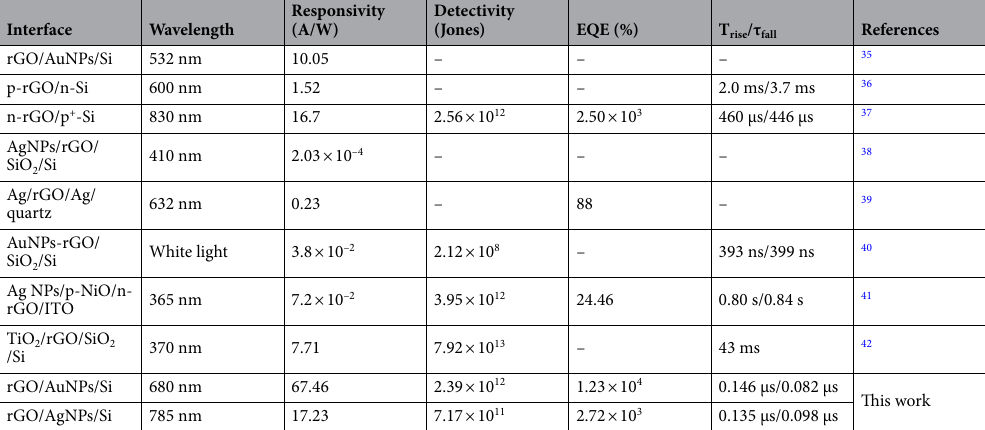
Table 2. Comparison of this work with earlier reported rGO photodetector.